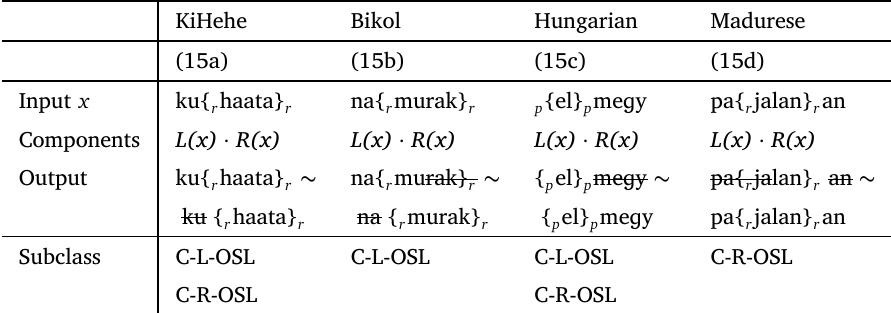
Table 5: C-OSL treatment for copying morphological subconstituents KiHehe Bikol Hungarian